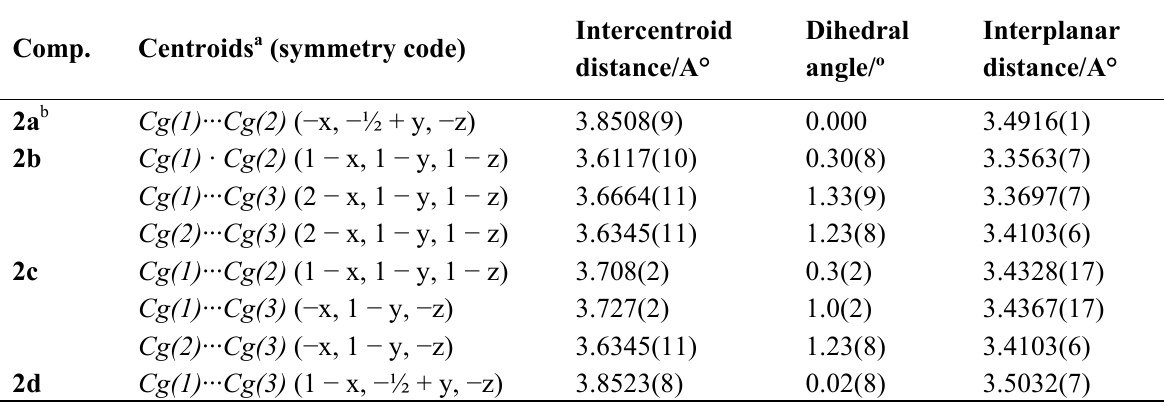
Table 5. Geometric parameters associated with π ··· π stacking interactions for compounds 2a–2d .